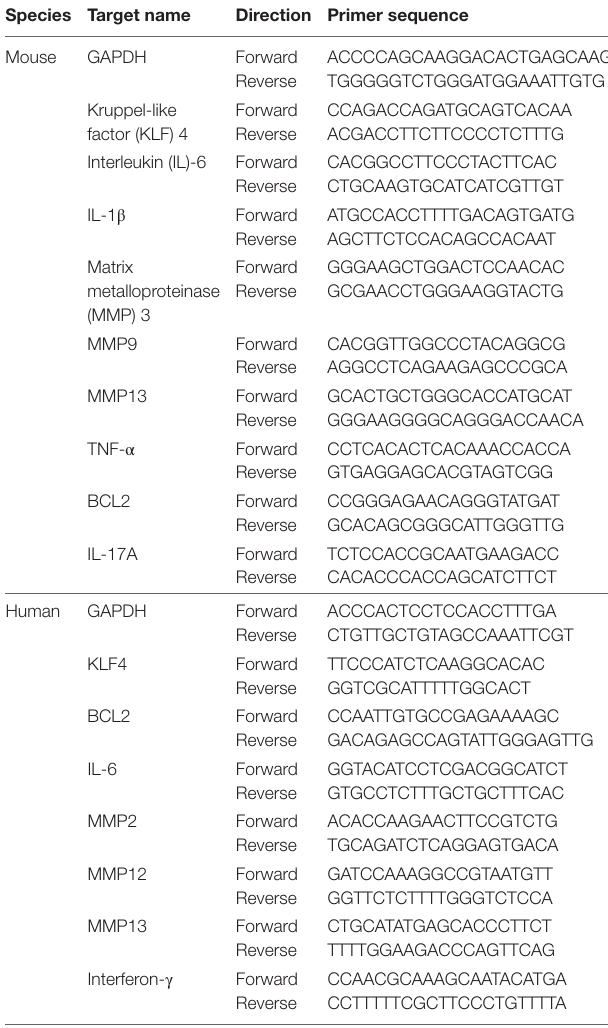
Table 1 | Primers used for real-time